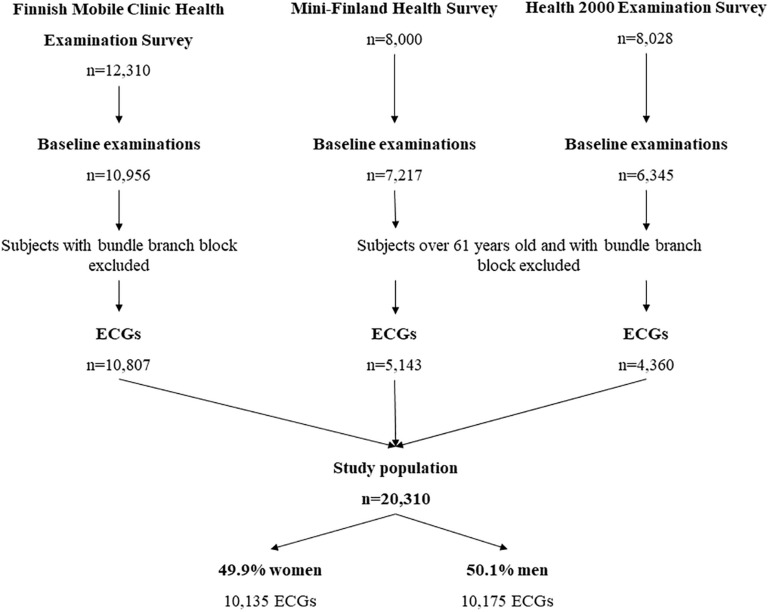
A flowchart of the patient populations.